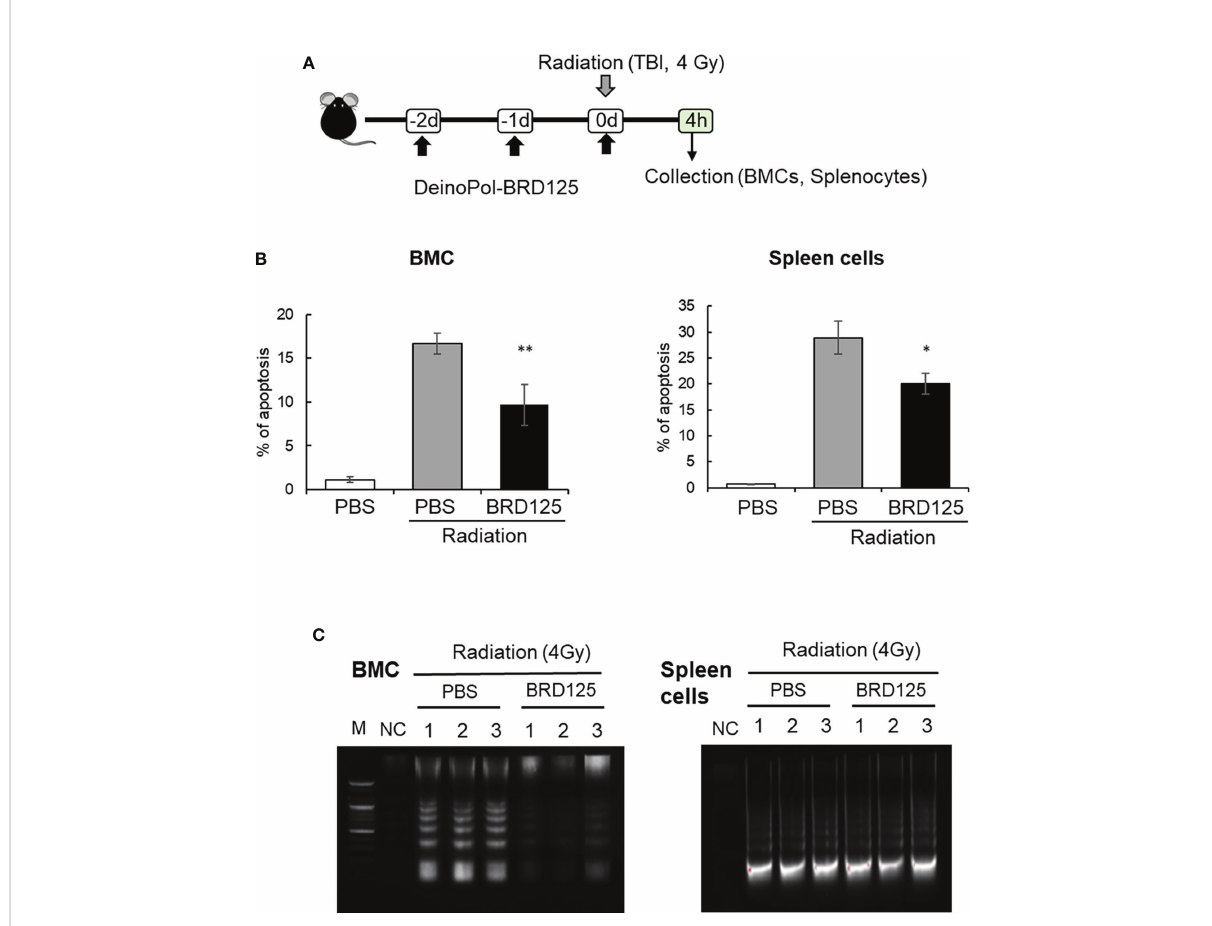
FIGURE 4 Protection of radiation-induced cell death by DeinoPol-BRD125 in vivo . (A – C) Mice (n=6) were injected intraperitoneally with DeinoPol-BRD125 (50 mg/kgBW) twice before and once after irradiation at a dose of 4 Gy. Bone marrow cells (BMCs) and spleen cells were collected at 4 h after irradiation. Schematic schedule of radiation-induced immune cell death experiment (A) . The ratio of apoptosis was calculated by staining BMCs (left) or spleen cells (right) with propidium iodide (PI) (B) . Protection of chromosomal DNA damage after irradiation by DeinoPol-BRD125 was measured by DNA fragmentation analysis. Chromosomal DNA from individual mice spleen and BMC were harvested at 4 h after irradiation and the pattern of DNA damage was visualized on 2% agarose gel. M: DNA ladder, NC: No DNA, PBS: PBS treated mice, BRD125: DeinoPol-BRD125 (00 m g/mice) treated mice (C) . *p<0.01 and **p<0.001 compared to PBS-injected irradiated